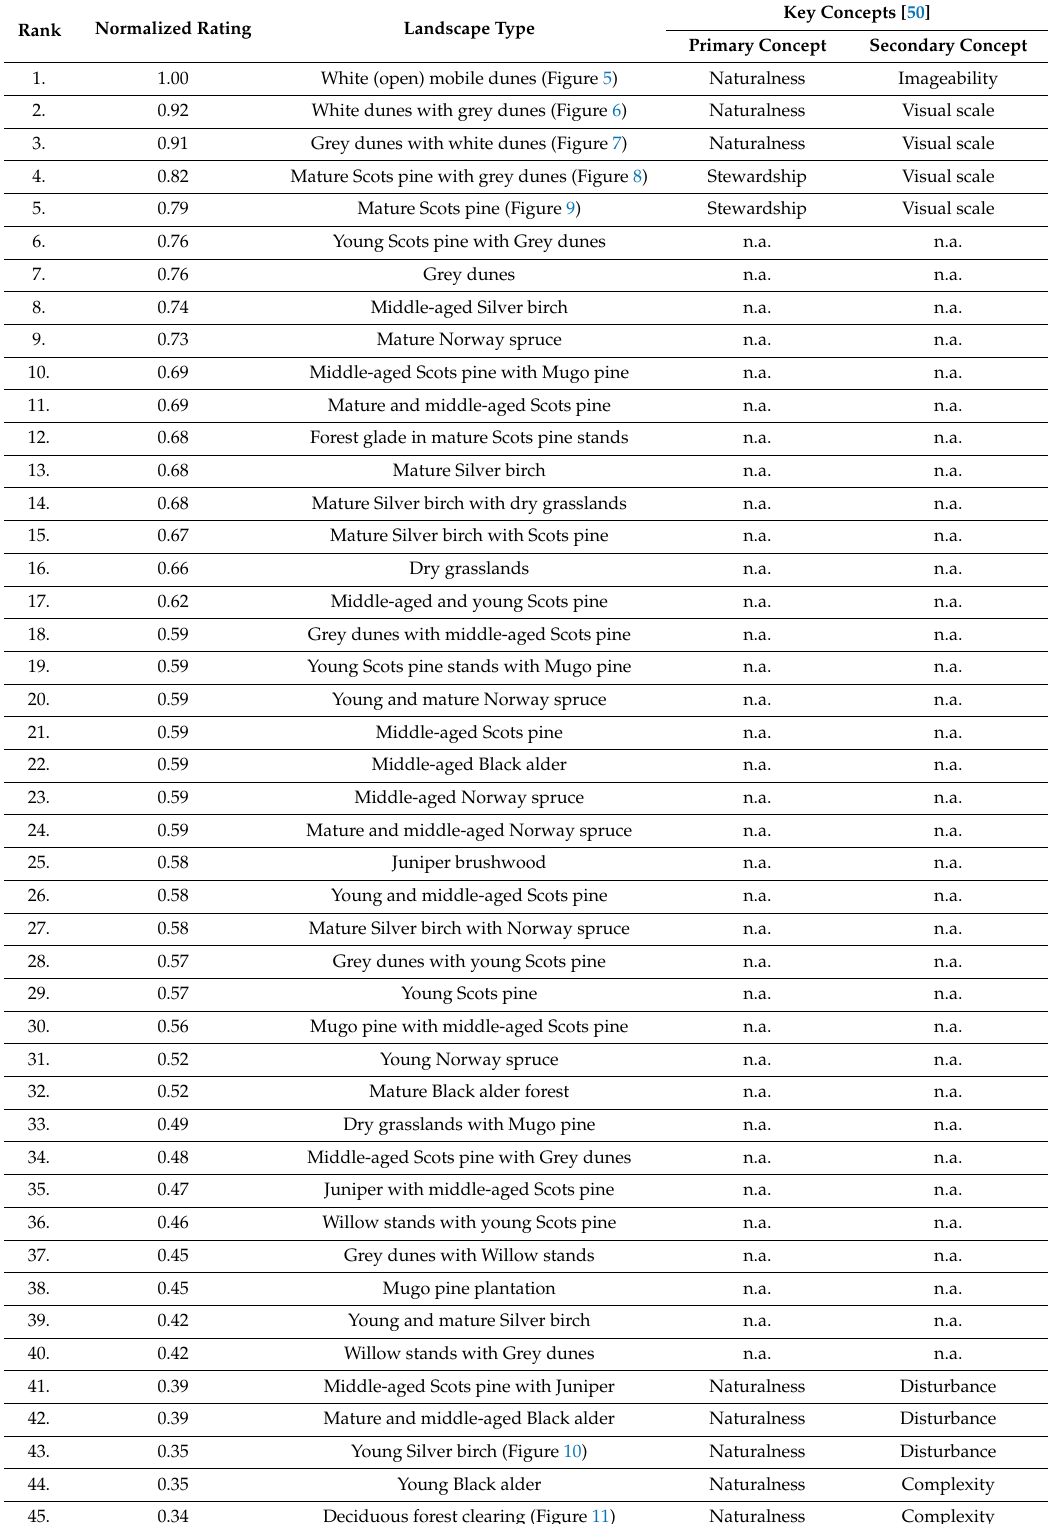
Table 3. Results of the paired comparison and the Delphi survey of the Curonian Spit landscapes.